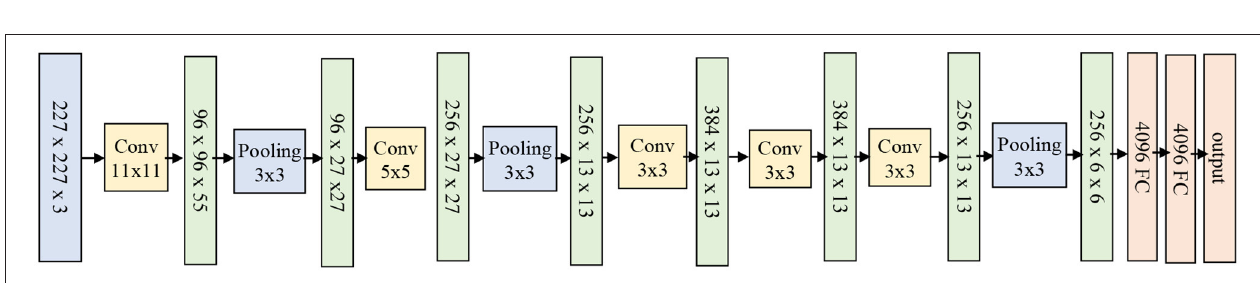
FIGURE 6 | The AlexNet